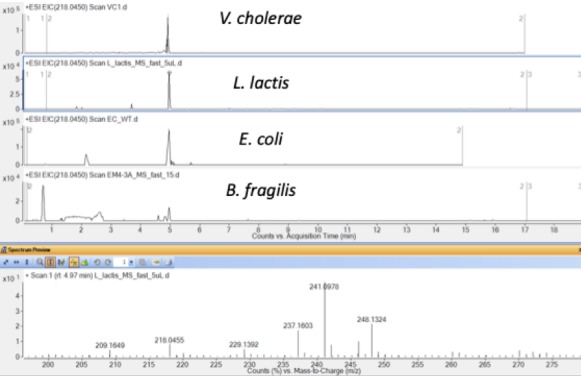
Production of ACNQ by V. cholerae V52, Lactococcus lactis lactis (ATCC 25285), E. coli K12, and Bacteroides fragilis (DSM 20481).